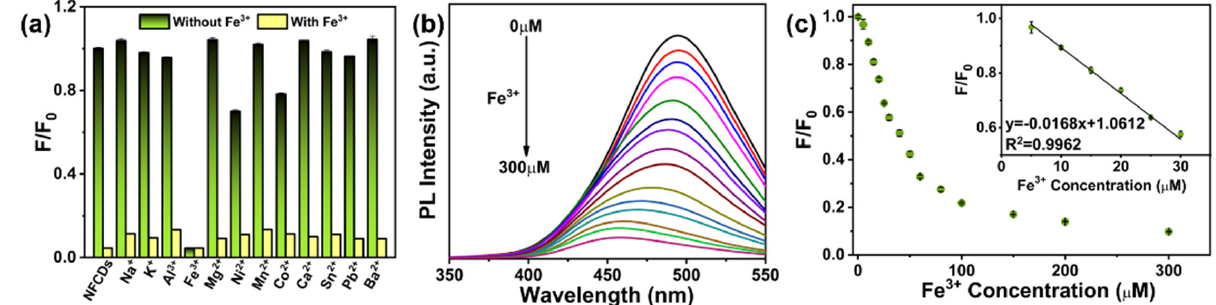
Figure 5. ( a ) The fluorescence quenching effect of different metal ions: dark green column-relative PL intensity with different metal ions; yellow column- relative PL intensity with different metal ions and Fe 3+ . ( b ) The PL spectra of NFCDs with various concentrations of Fe 3+ , ranging from 0 to 300 µ M. ( c ) The relative PL intensity (F/F 0 ) decay with various concentrations of Fe 3+ : inset: linear relationship between quenched intensity with concentrations of Fe 3+ , y = − 0.0168x + 1.0612, R 2 = 0.9962.